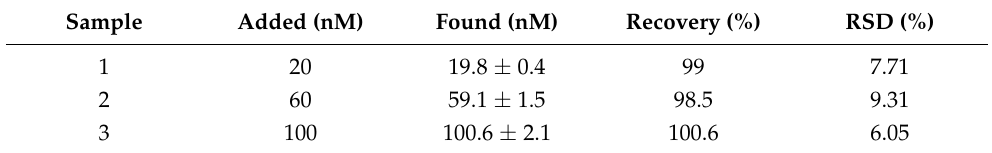
Table 2. Recovery experiments of SA in diluted human serum using this method ( n = 3).